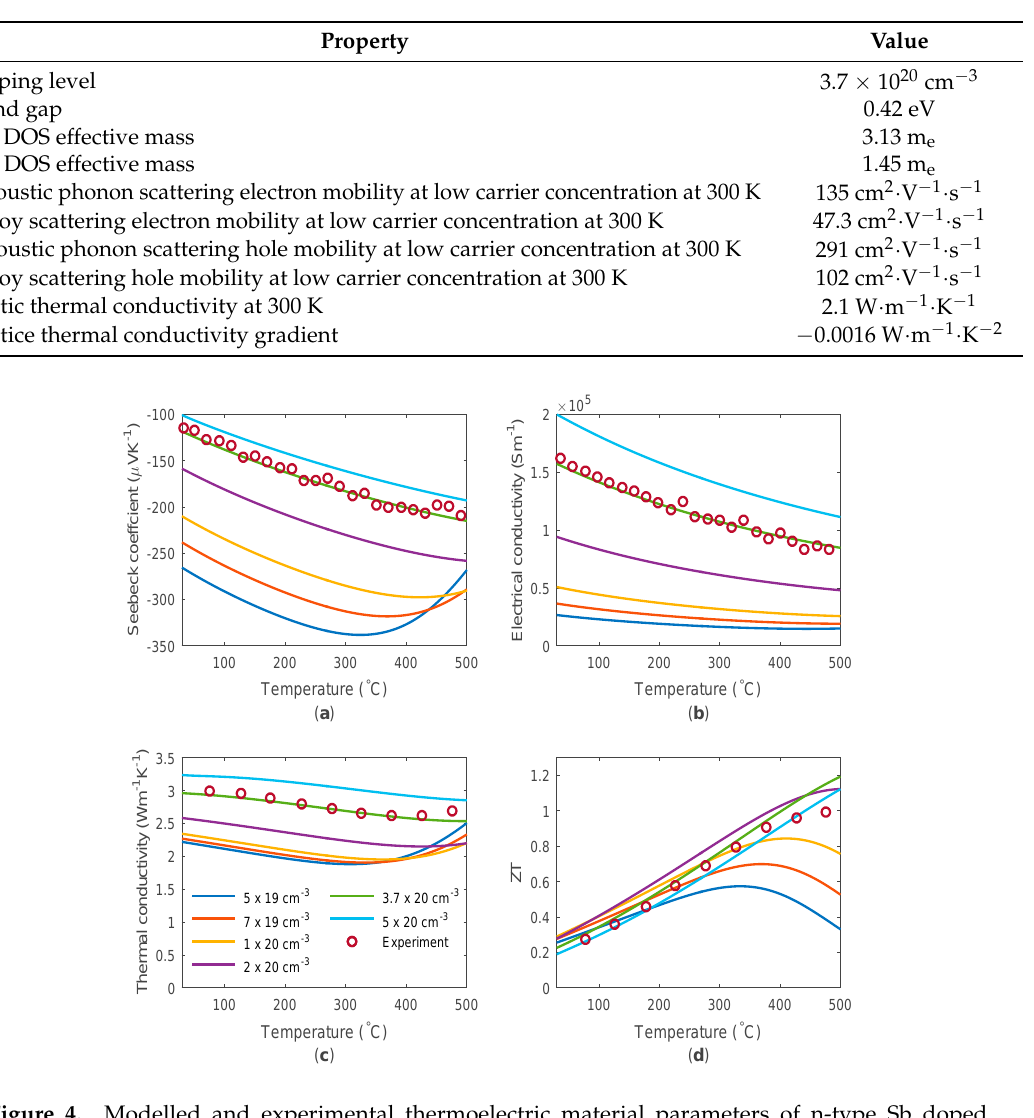
Table 2. Properties used to match modelled n-type silicide material to experimental data.